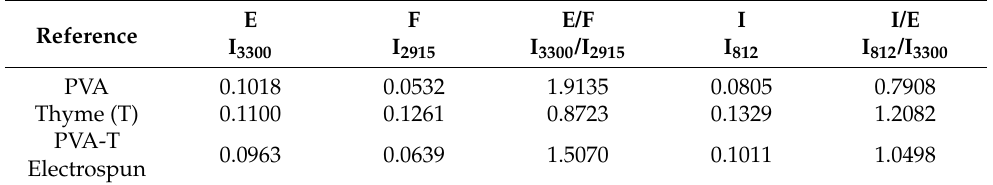
Table 7. Band intensity of FTIR spectra of PVA, thyme, and electrospun PVA − thyme nanofiber veils. Reference